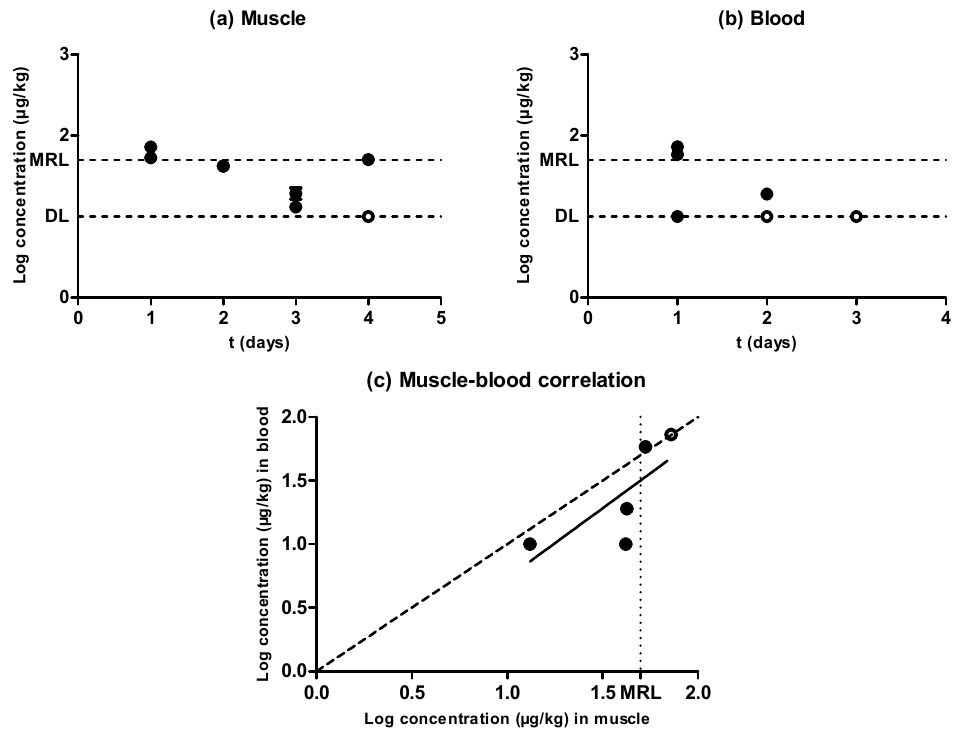
Figure 4. Evolution of the concentration of amoxicillin in muscle ( a ) and blood ( b ) samples obtained from pigs treated with amoxicillin and slaughtered at preset intervals within the withdrawal period. Muscle sample concentrations were determined by high performance liquid chromatography with fluorescence detection (HPLC-FLD), and blood sample concentrations by LC–MS/MS. The DL dotted line represents the detection limit of the analytical technique for amoxicillin, and the MRL dotted line represents the maximum residue limit of amoxicillin in muscle as established by Regulation (EEC) No. 2377/90. Relationship among the concentrations of amoxicillin detected in blood and muscle samples ( c ). The bisecting dotted line represents the 1:1 correlation if both matrixes contained the same concentration of amoxicillin.